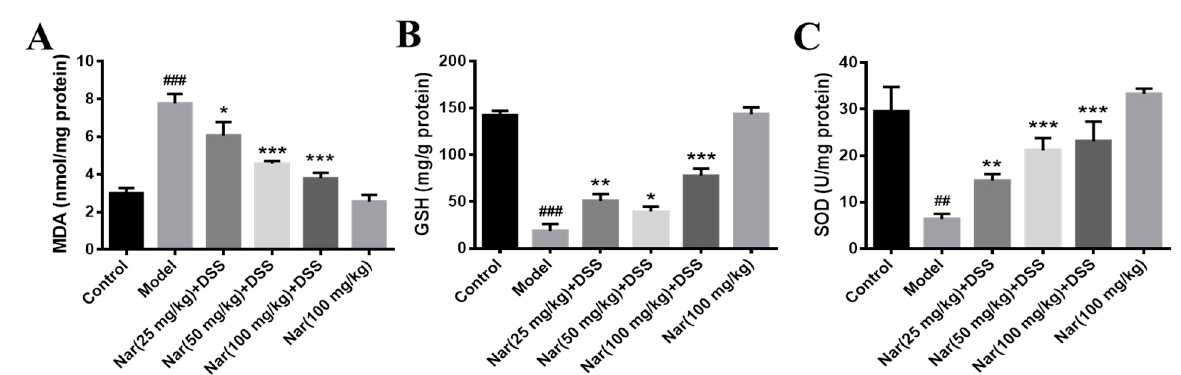
Figure 4. Effects of naringin on oxidative stress levels in mice with colitis. The level of MAD ( A ), GSH ( B ) and SOD ( C ) were detected in the colon tissues of each group. Data are presented as means ± SD ( n = 3). ## p < 0.01 and ### p < 0.001, compared with the control group. * p < 0.05, ** p < 0.01 and *** p < 0.001, compared with the model